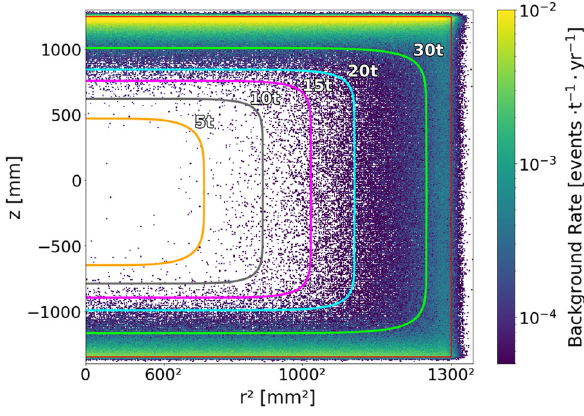
Fig. 4 Spatial distribution of external background events inside the instrumented volume for 100 years of DARWIN run time. The colored lines indicate the contours of the optimized fiducial volumes containing different LXe target masses. The 5t fiducial volume is used for the sensitivity estimate presented